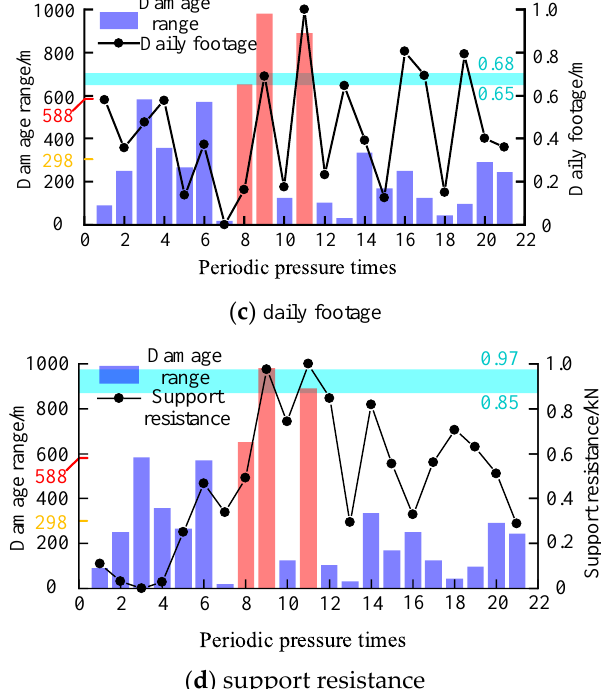
Figure 15. Critical interval and effectiveness of early warning index of mining-induced stress intensity (taking “strong” as an example).